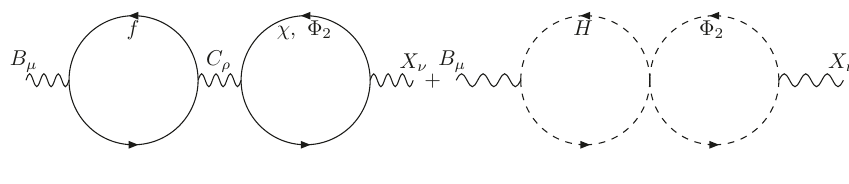
Figure 5. The 2-loop corrections for the B µν X µν